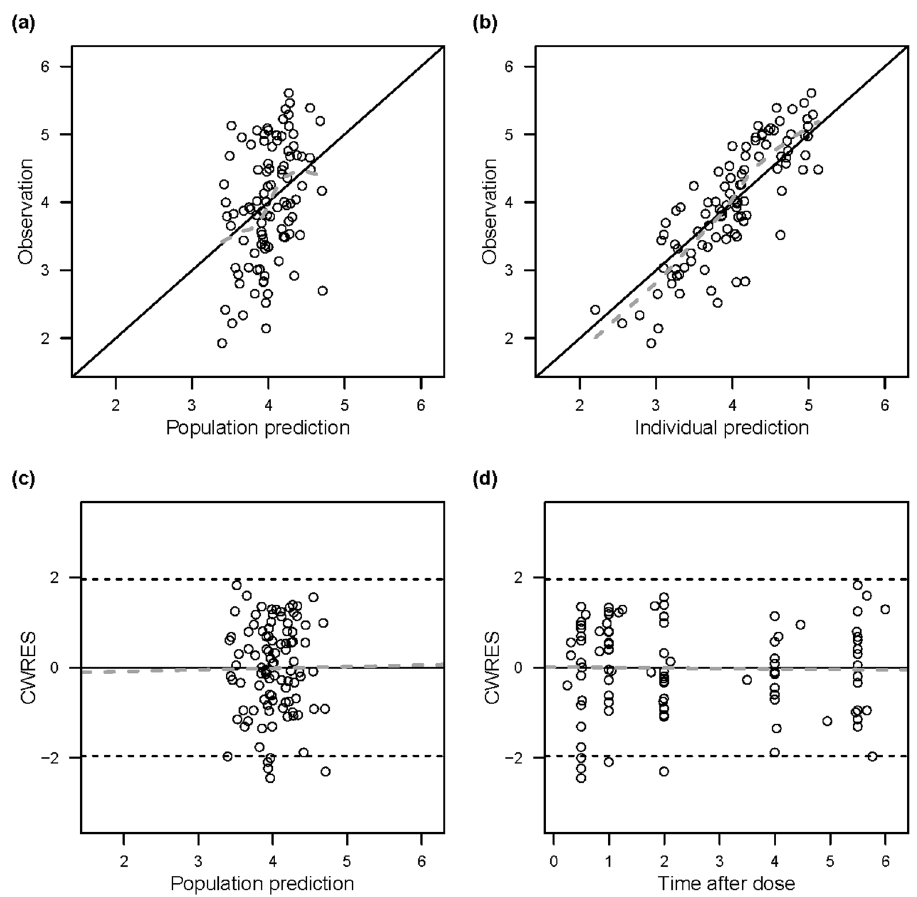
Figure 1. Goodness-of-fit plots for sildenafil. ( a ) Population predictions versus observed concentrations; ( b ) Individual predictions versus observed concentrations; ( c ) Conditional weighted residuals (CWRES) versus population predictions; and ( d ) CWRES versus time. The solid lines represent the line of unity. The dashed lines represent the linear regression